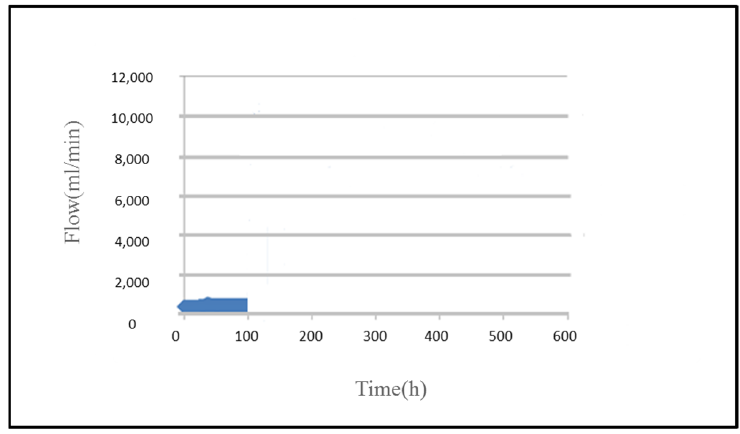
Figure 20. Curve of flow inside PEM water electrolyzer.